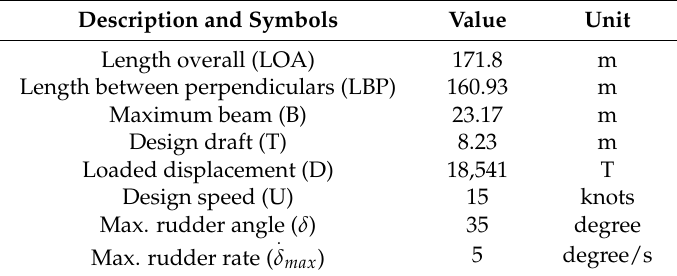
Figure 5. Coordinate system of ship maneuvering motion. Table 4. Ship particulars of Mariner class vessels.